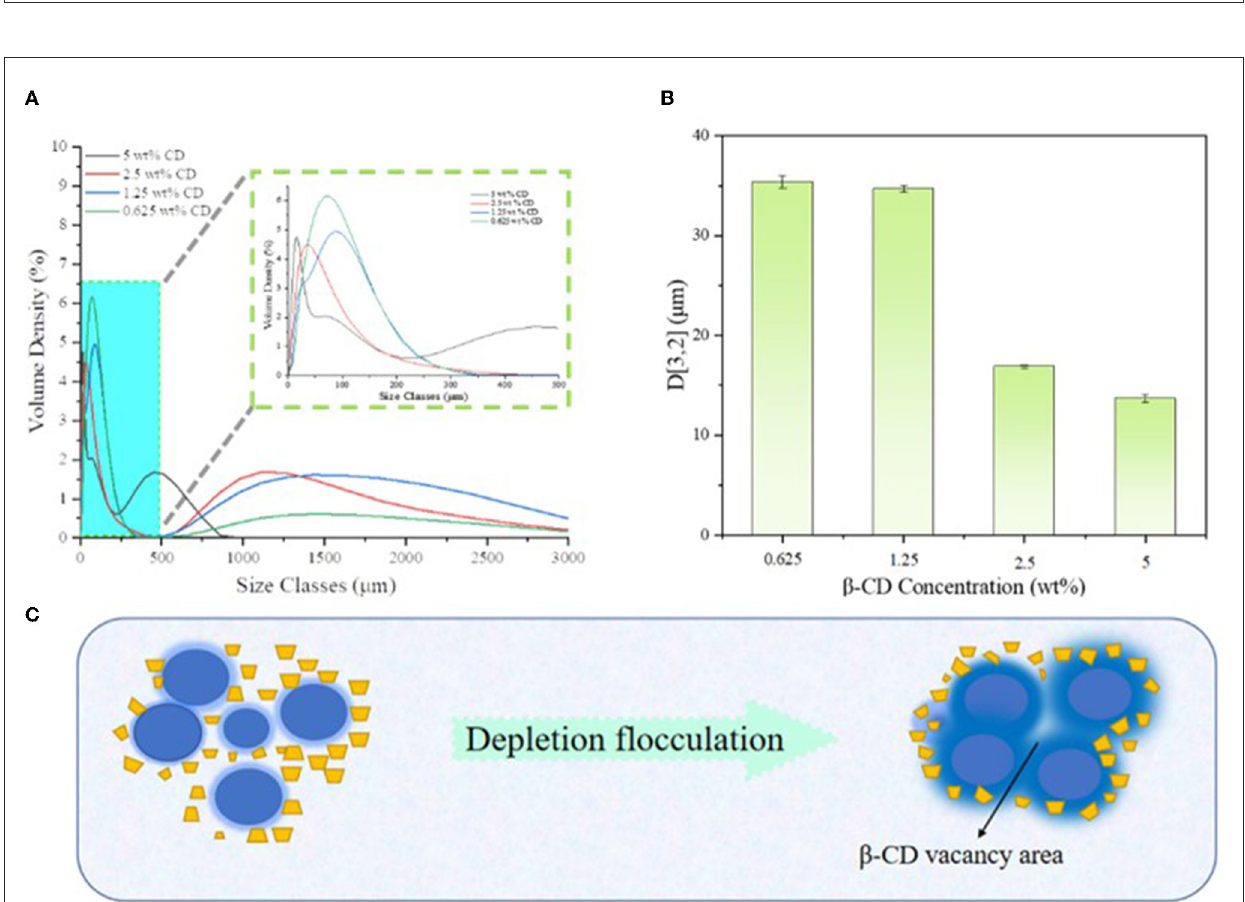
FIGURE4 Particle size distribution of different β -CD emulsions (A) , corresponding D [3,2] values (B) , and schematic diagram of emptying flocculation (C).